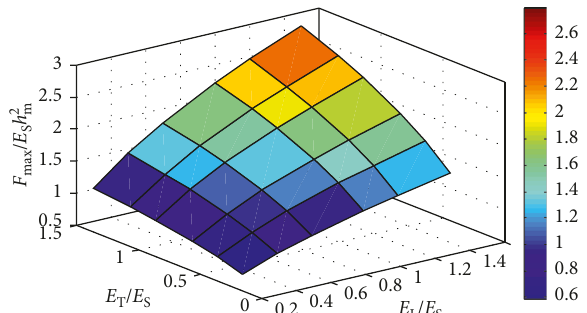
Figure 5: The three-dimensional diagram of the relationship be- h 2 tween F / E , E L / E S , and E T / E S . max S m